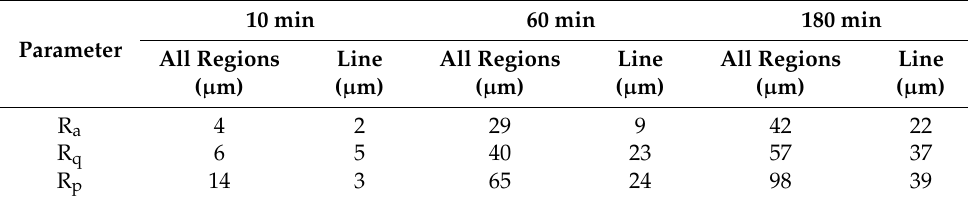
Table 4. Surface roughness parameters of all regions and BB’ line in Figure 11.